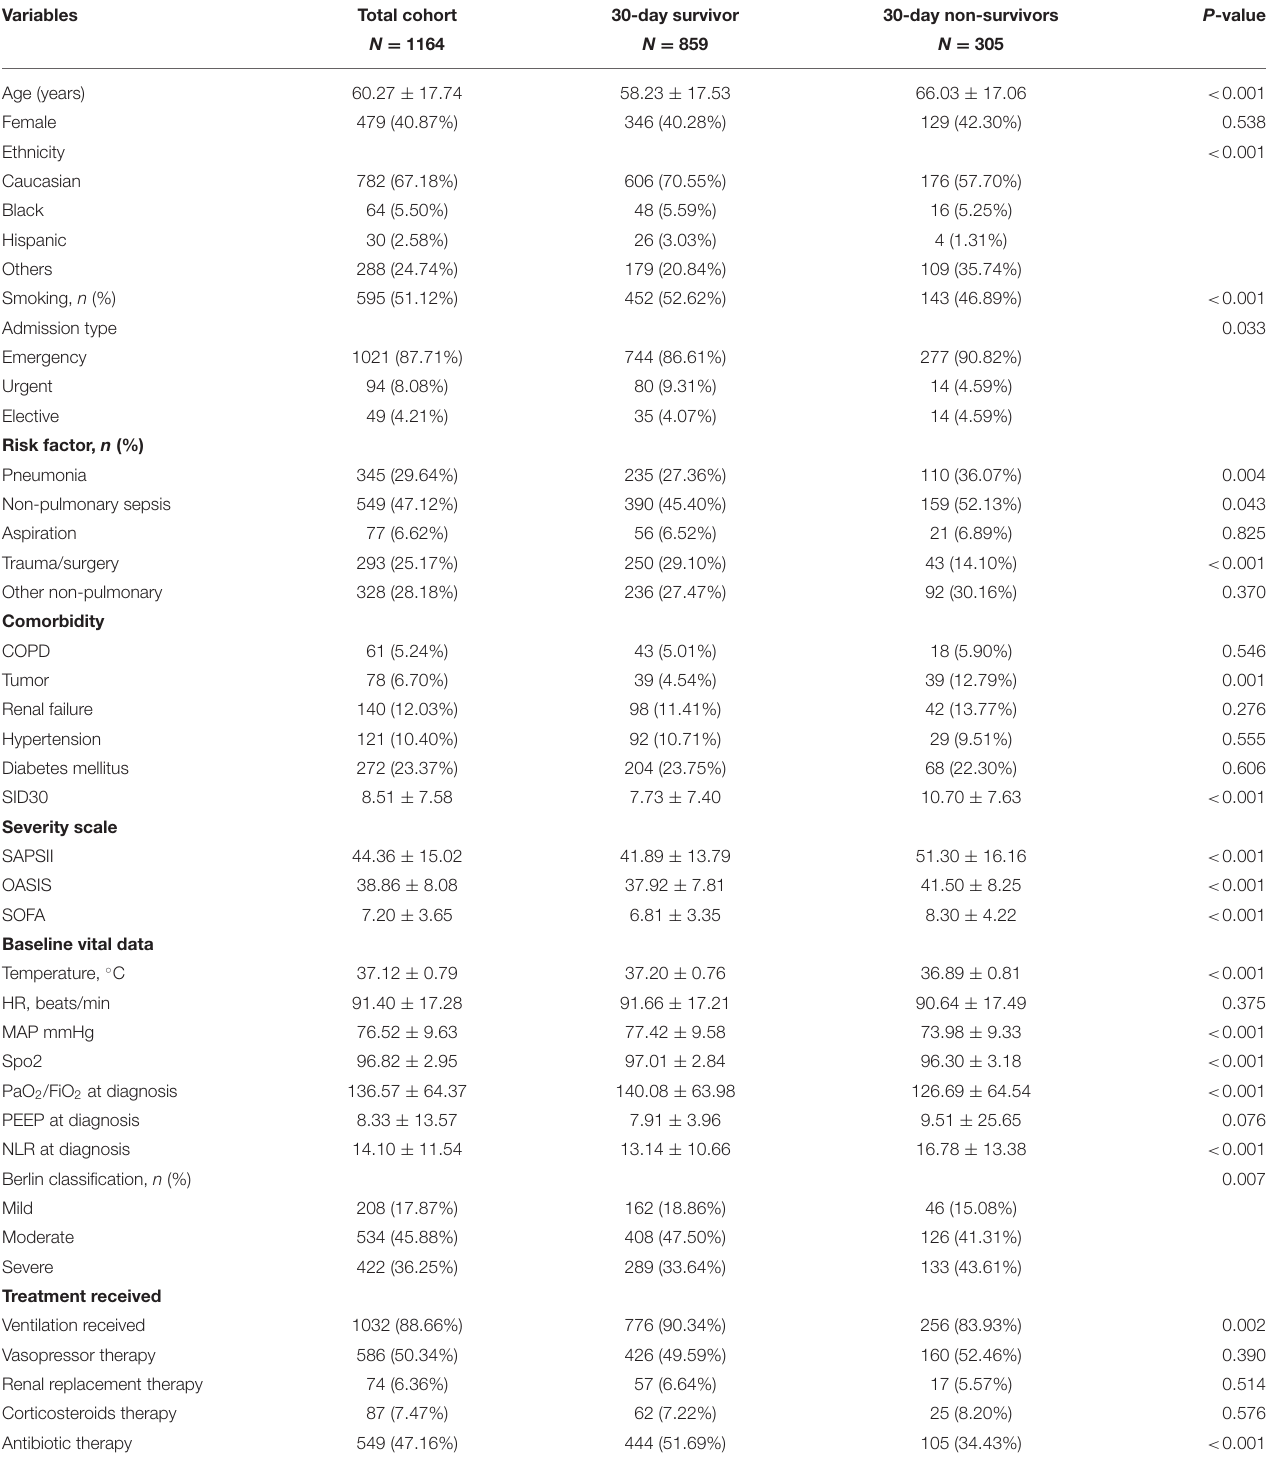
TABLE 1 | Baseline characteristics of total cohort, 30-day survivors, and 30-day